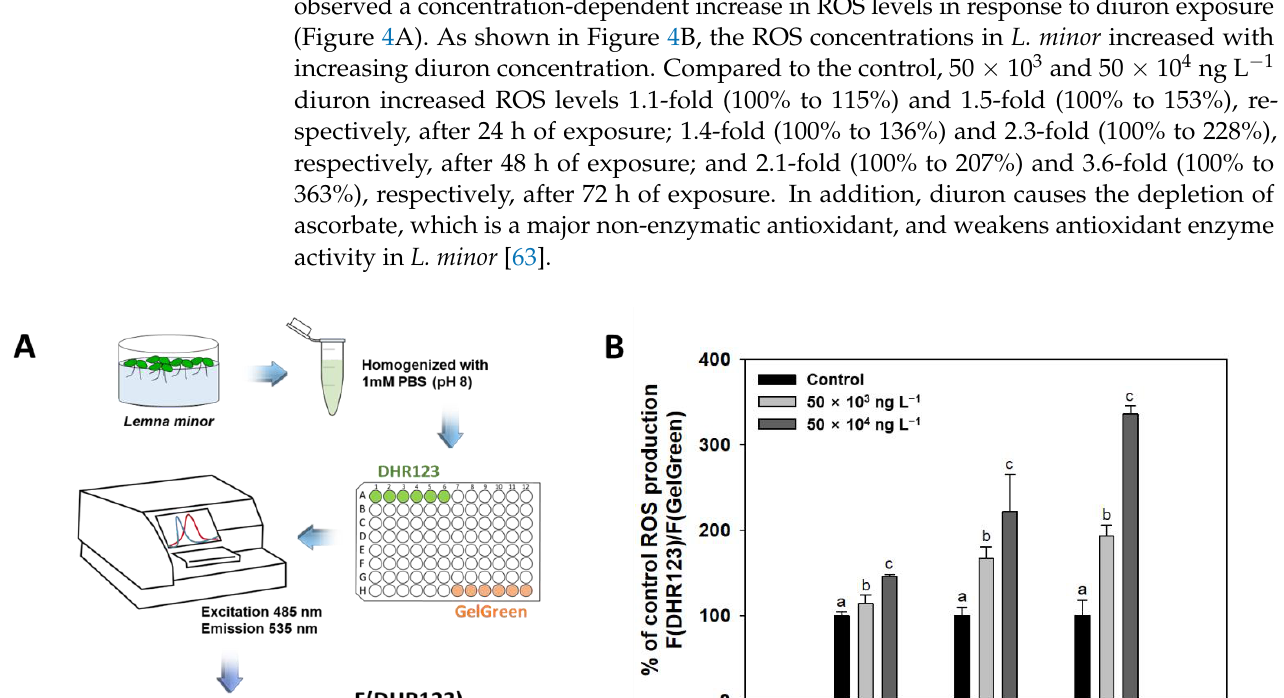
Table 2. Effect of diuron (50 × 10 3 and 50 × 10 4 ng L −1 ) on induced chlorophyll a fluorescence parameters including maxi- mum electron transport rate (ETR max ) and non-photochemical quenching (NPQ) in Lemna minor exposed for 24, 48, and 72 h. Data represent mean ± standard deviation of three replicates. Different letters indicate statistically significant differences at p < 0.05 (one-way ANOVA, LSD).